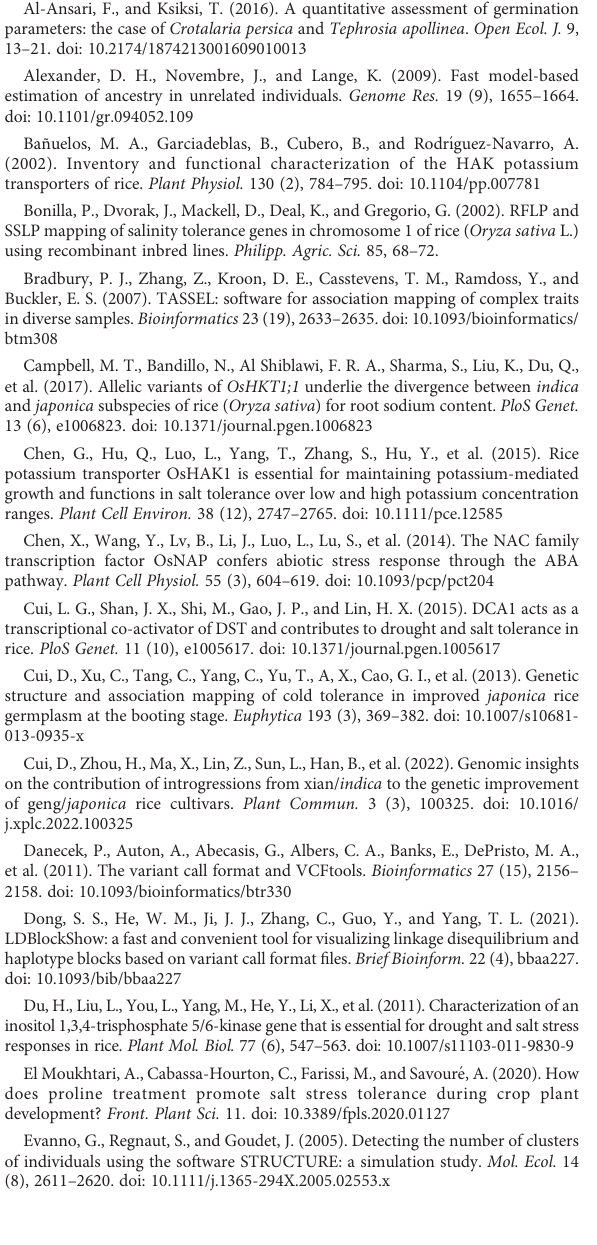
on day 4 (4dGP). ( C )GP onday 5 (5dGP). ( D )GPon day 6 (6dGP). ( E )GP on day 7 (7dGP). ( F ) GI. SUPPLEMENTARY FIGURE 4 Average GP on days 3 through 7 under salt stress. SUPPLEMENTARY FIGURE 5 Results for Q-Q plot of germination potential (GP) on different days and germination index (GI) under salt stress. ( A ) GP on day 3 (3dGP). ( B ) GP on day 4 (4dGP). ( C ) GP on day 5 (5dGP). ( D ) GP on day 6 (6dGP). ( E ) GP on day 7 (7dGP). ( F )